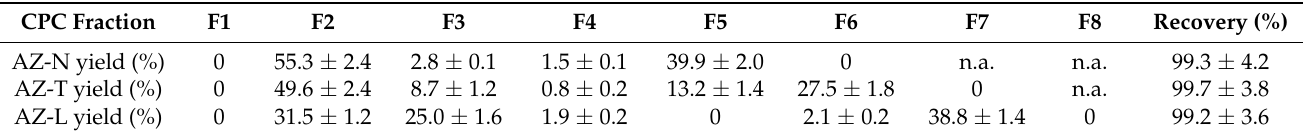
Table 1. Yields (%, w / w ) of the individual fractions (F1–F8) and the recovery rate from CPC runs with Arizona liquid system and the medium polar solvent composition N (AZ-N), non-polar solvent composition T (AZ-T) and polar solvent composition L (AZ-L); n.a., not available. Data points represent the mean value ± standard deviations of three samples.